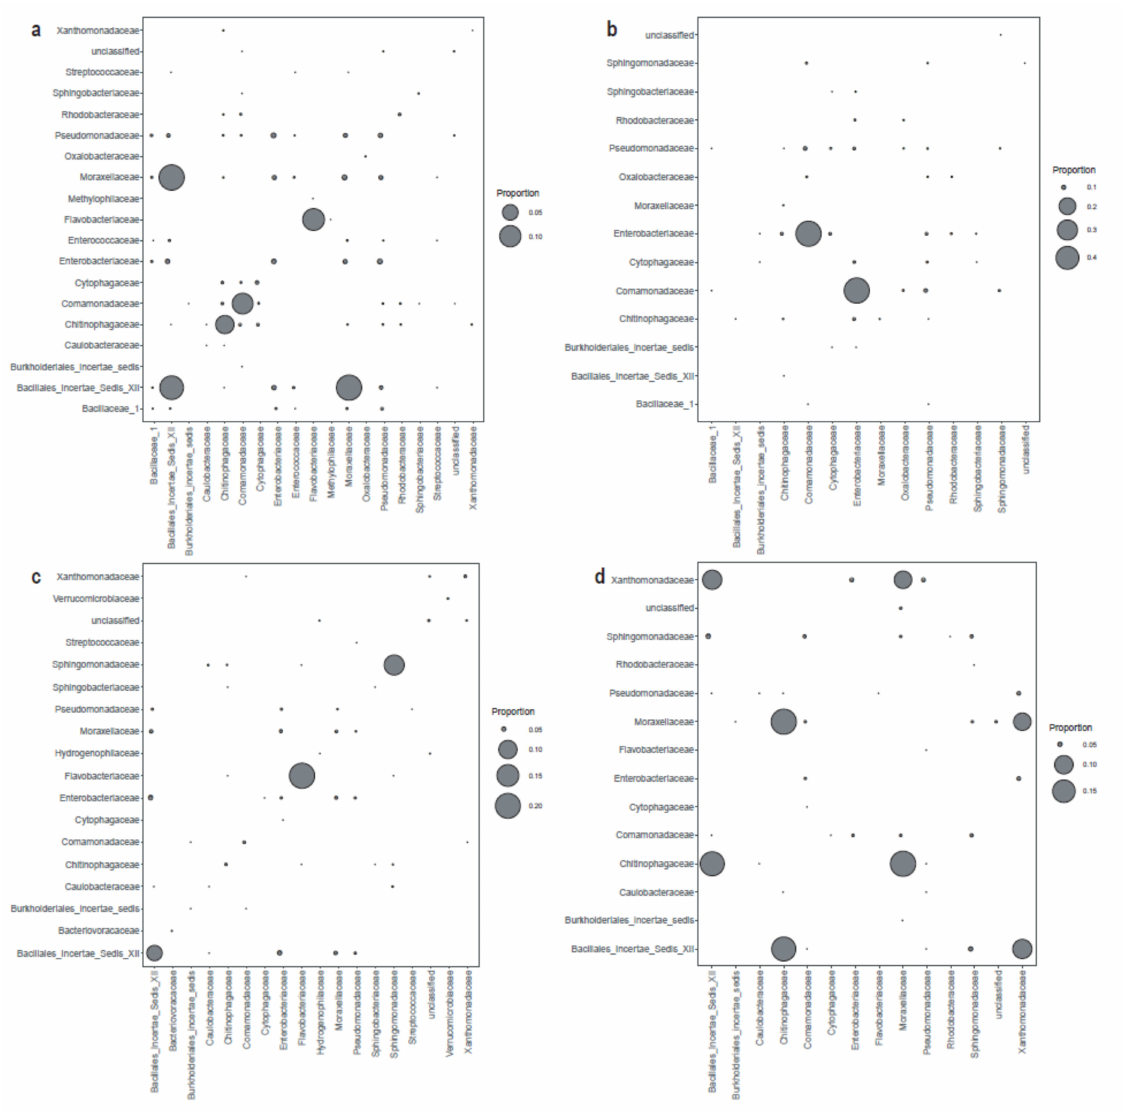
Figure 7. The pairwise taxonomic structure of the network edges in melt ponds and periglacial rivers. ( a ): the positive edges in melt ponds, ( b ): the positive edges in melt ponds, ( c ): the positive edges in periglacial rivers, ( d ): the positive edges in periglacial rivers. The size of the bubble represents the proportion of edges in the co-occurrence